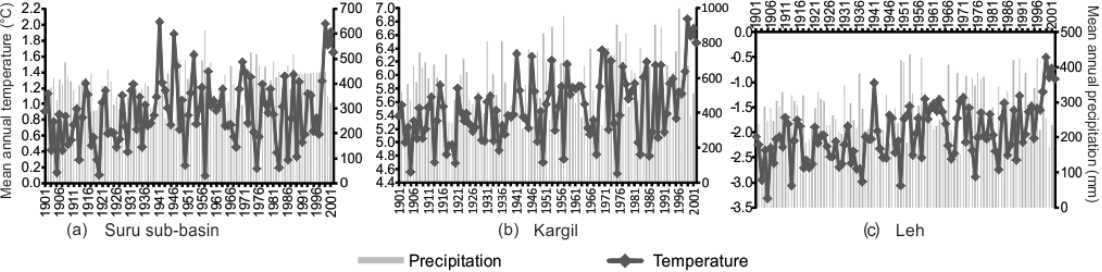
Figure 4. Mean annual temperature and precipitation patterns of gridded data derived from the Climate Research Unit (CRU) time series